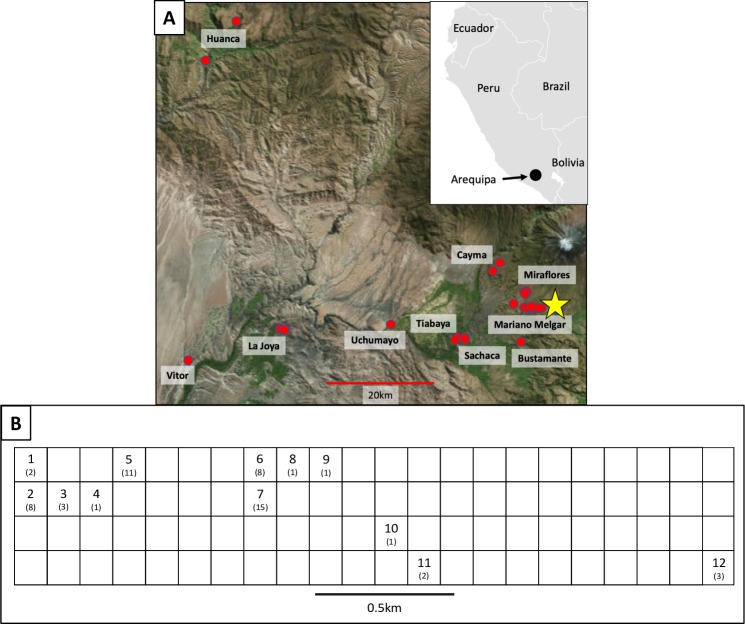
Map of sample collection locations in A) Arequipa, Peru and the B) Mariano Melgar district. A) All 123 T. cruzi samples used in this analysis were collected within 100km of Arequipa, Peru from 2008–2015. Sampled T. cruzi isolates are represented by red dots. Mariano Melgar—the city center and most densely-sampled district—is indicated with a yellow star. Inset shows the location of Arequipa in southern Peru. Map of Arequipa was obtained from https://landlook.usgs.gov, sample locations were plotted using QGIS v. 3.4 [8], and inset was modified from https://commons.wikimedia.org/wiki/Atlas_of_the_world [9]. B) Blocks from which T. cruzi were collected in the Mariano Melgar district (N = 56) are numbered 1–12 with the number of samples collected per block in parentheses. No parasites were collected in unlabeled blocks. Blocks are displayed in a grid to maintain privacy with black lines representing streets separating blocks.